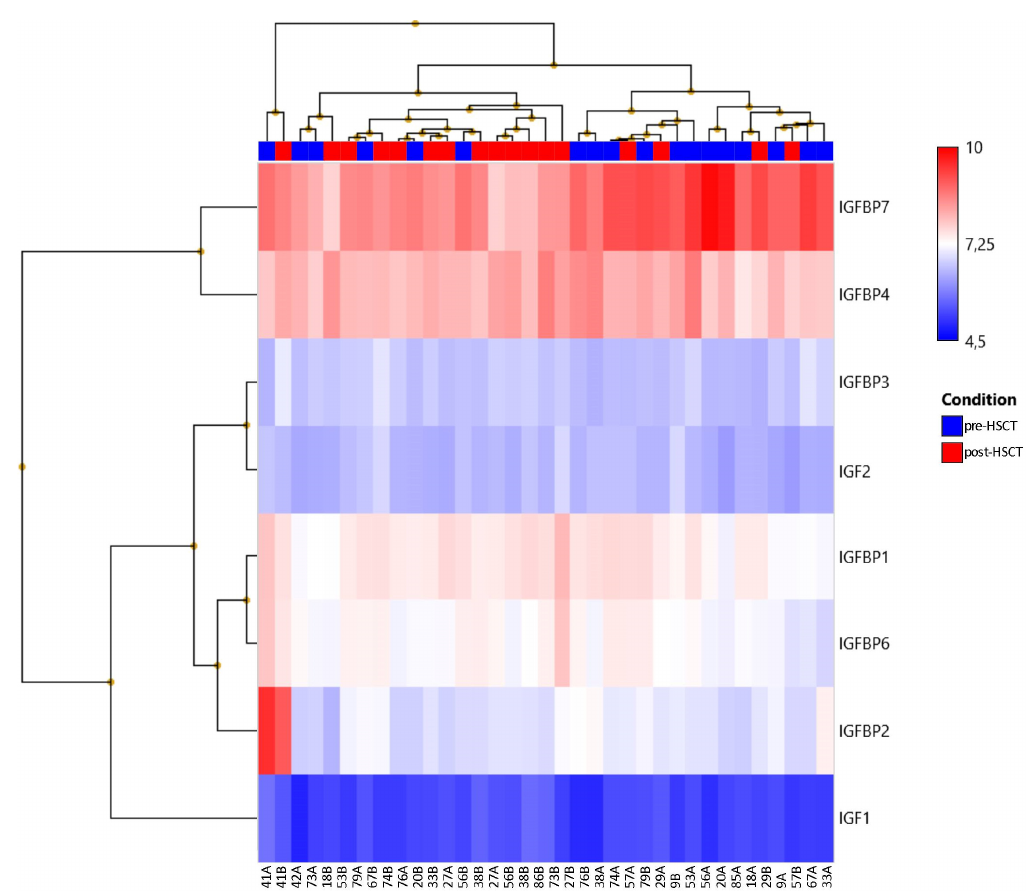
Figure 2. Expressions of genes encoding IGFs and IGFBPs in the pre-HSCT group and post-HSCT group. HSCT, hematopoietic stem cell transplantation; IGF, insulin growth factor; IGFBP, insulin growth factor-binding protein.